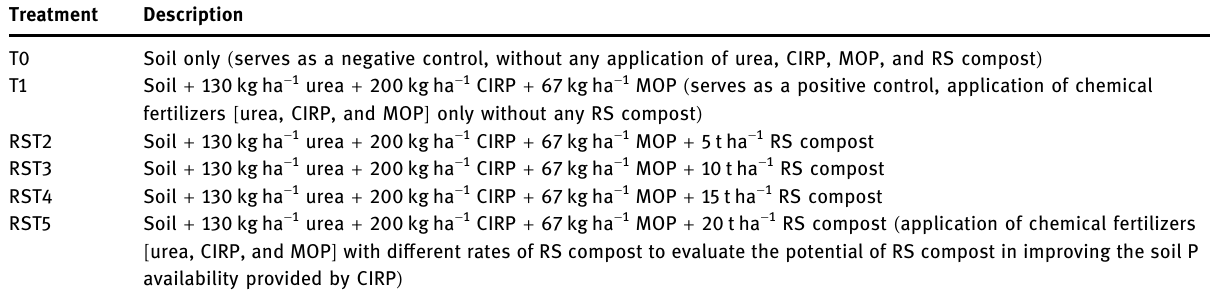
Table 3: Description of treatments evaluated in the pot experiment Treatment